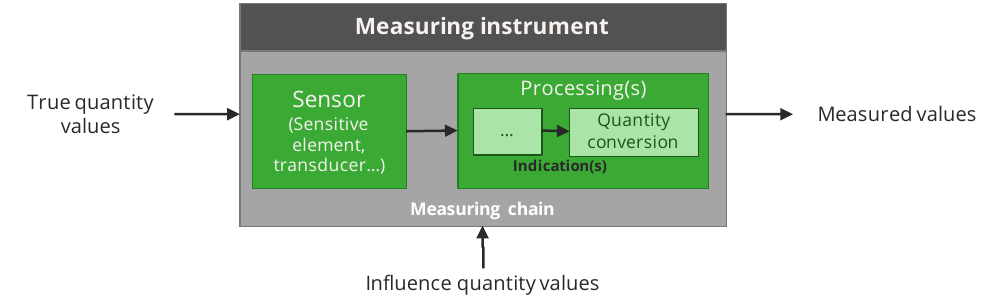
Figure 1. Model adopted for the measuring instruments. It is considered as a grey box, for example, an algorithm mimics the behaviour of the components of the measuring chain without however modelling each part